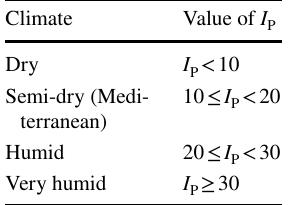
Table 4 Climate according to I